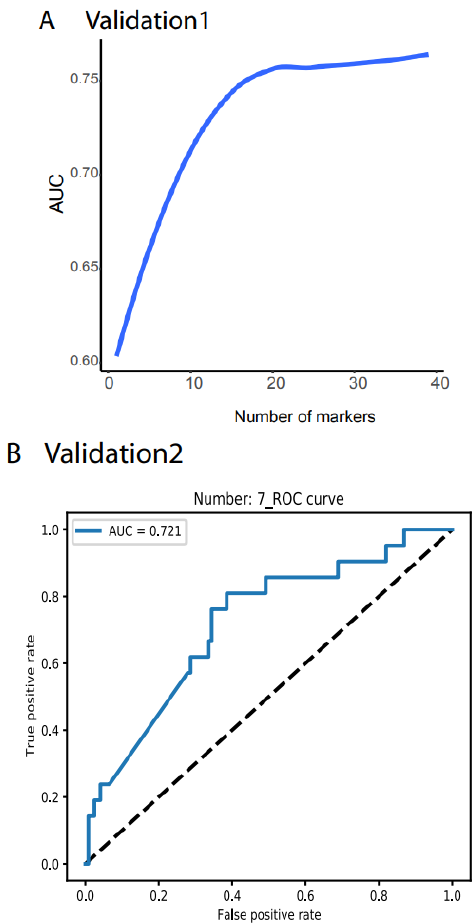
(Figure 2C). This indicated that our system can discriminate normal vs. cancer with >0.96 AUC with 51 noncoding RNA